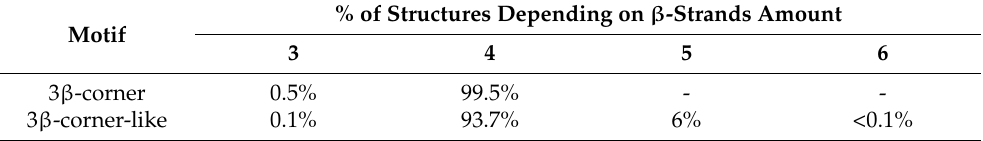
Table 3. Distribution of 3 β -corners and 3 β -corner-like structures depending on number of β -strands in their secondary structure.